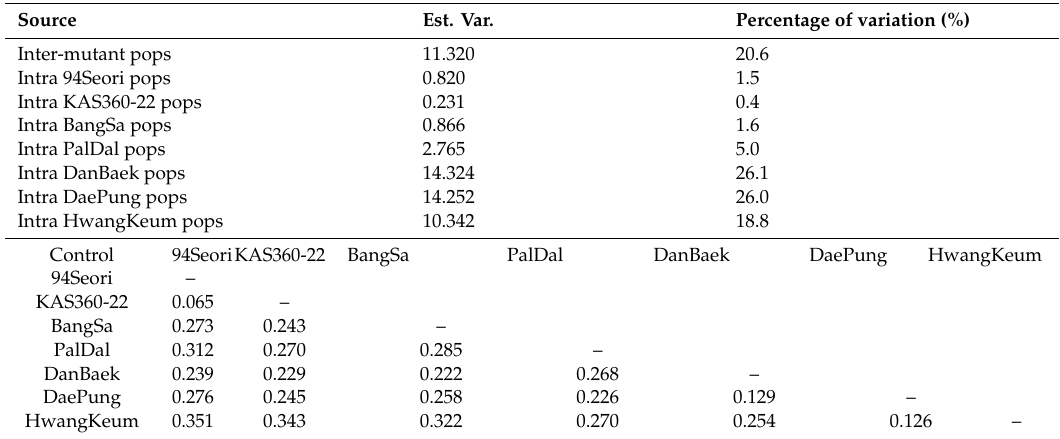
Table 5. Analysis of molecular variance results and pairwise Fst values estimated from 208 soybean MDP